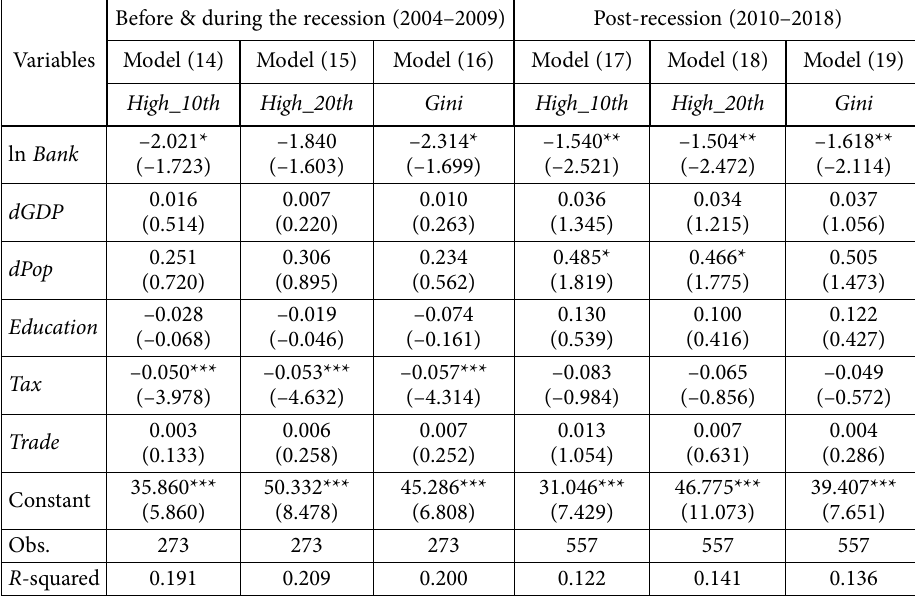
Table 5. Results of the robustness test (sample split into two